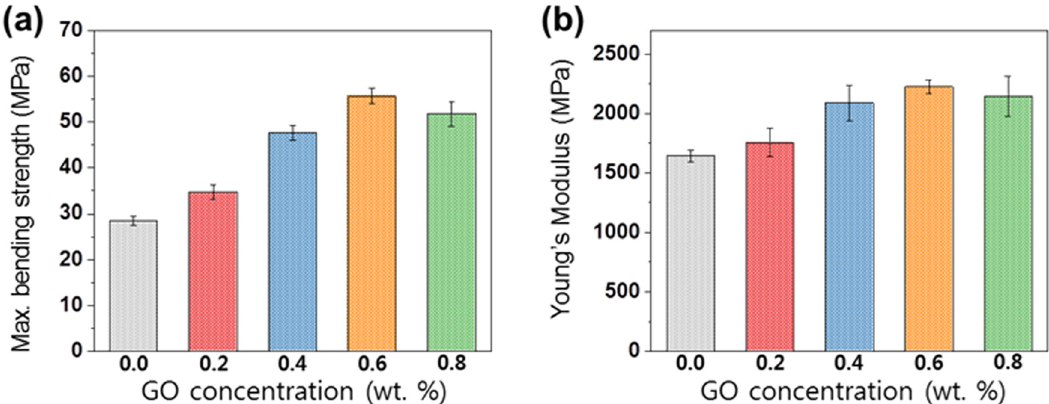
Figure 6: Mechanical properties of the EP/GO: ( a ) bending strength and ( b ) Young ’ s modulus.